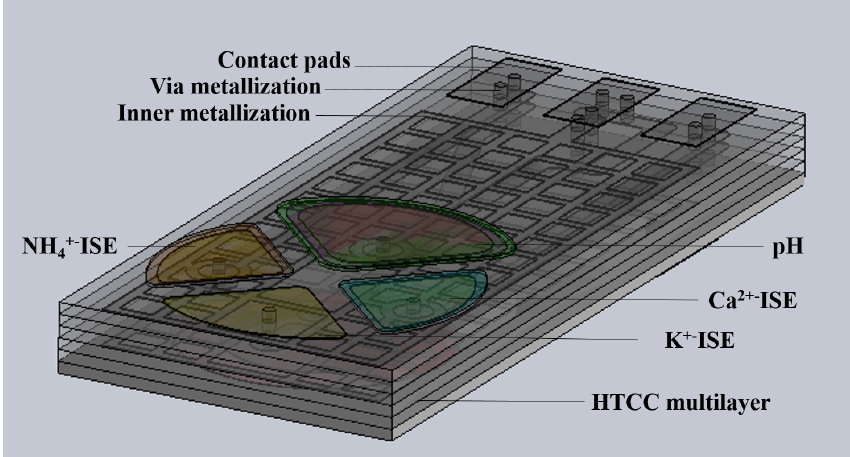
Figure 1. The HTCC-based sensor array (CAD drawing) – top view with ion-selective electrodes, e.g. pH, potassium, ammonium, and calcium ions.